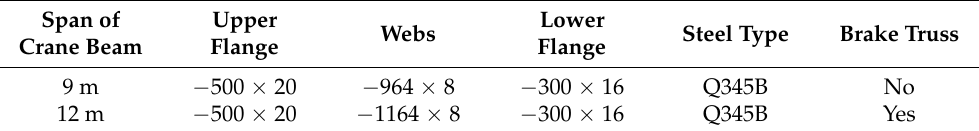
Table 4. Crane beam size (mm).